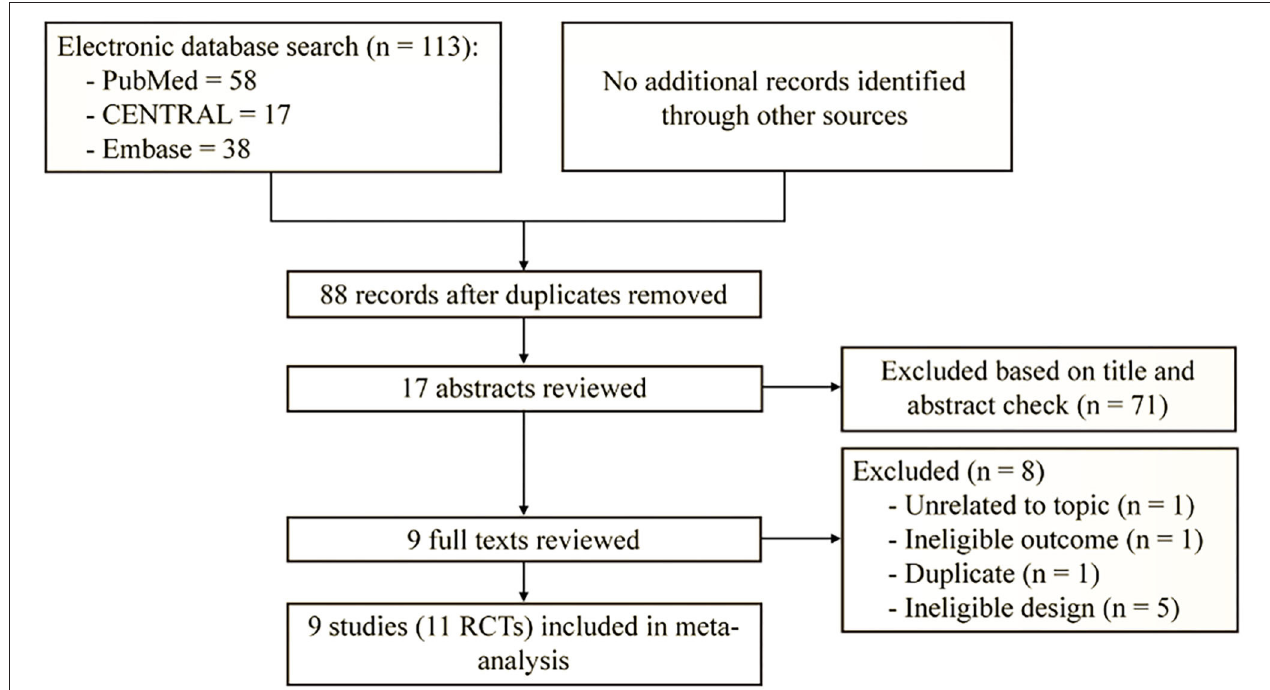
FIGURE 1 | Flow diagram of retrieval and selection of literature. Other sources present reference lists of included